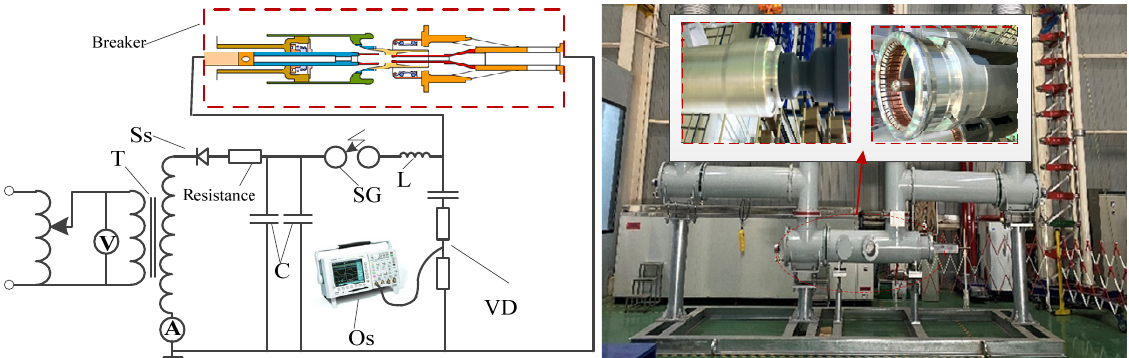
Figure 1. Circuit diagram of circuit breaker on load breaking and making tests. C—Impact capaci- tor; SG—steepen ball; R—tuning resistance; L—tunable inductor; VD—resistance voltage divider; CRO—oscilloscope.